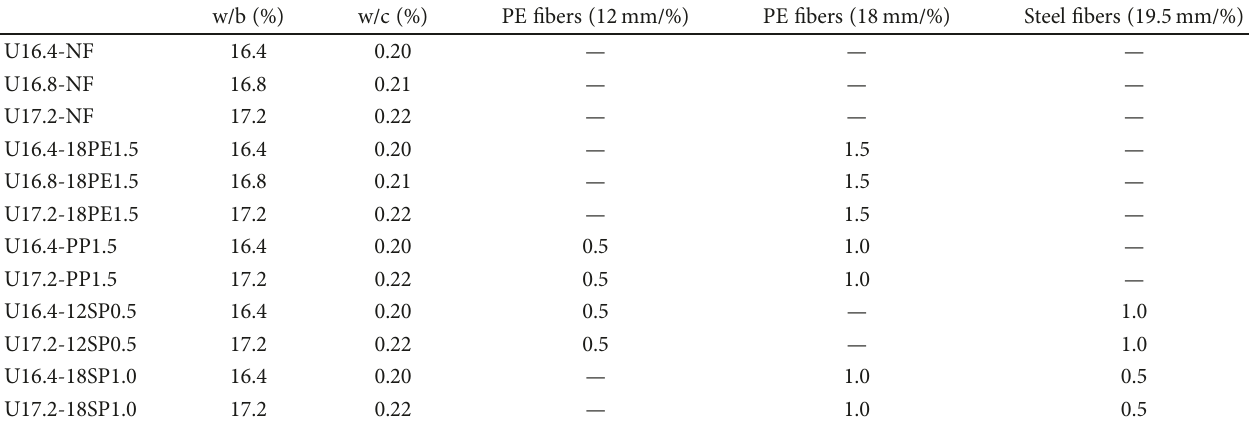
Table 2: Details of various w/b of specimens and fi ber hybridization.